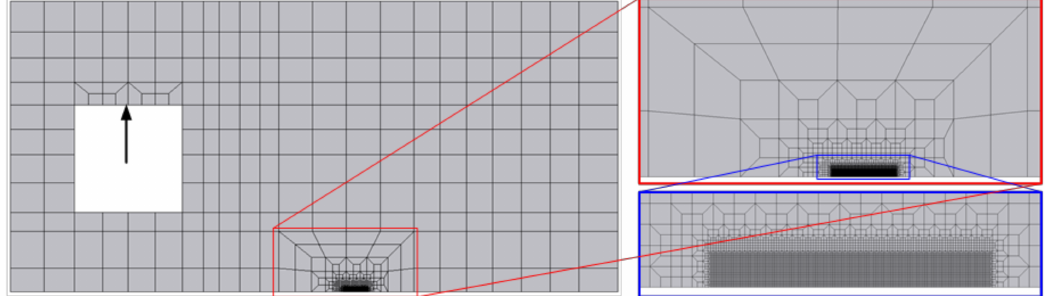
Figure 2. Finite element mesh. The refined mesh is shown in the image on the bottom left